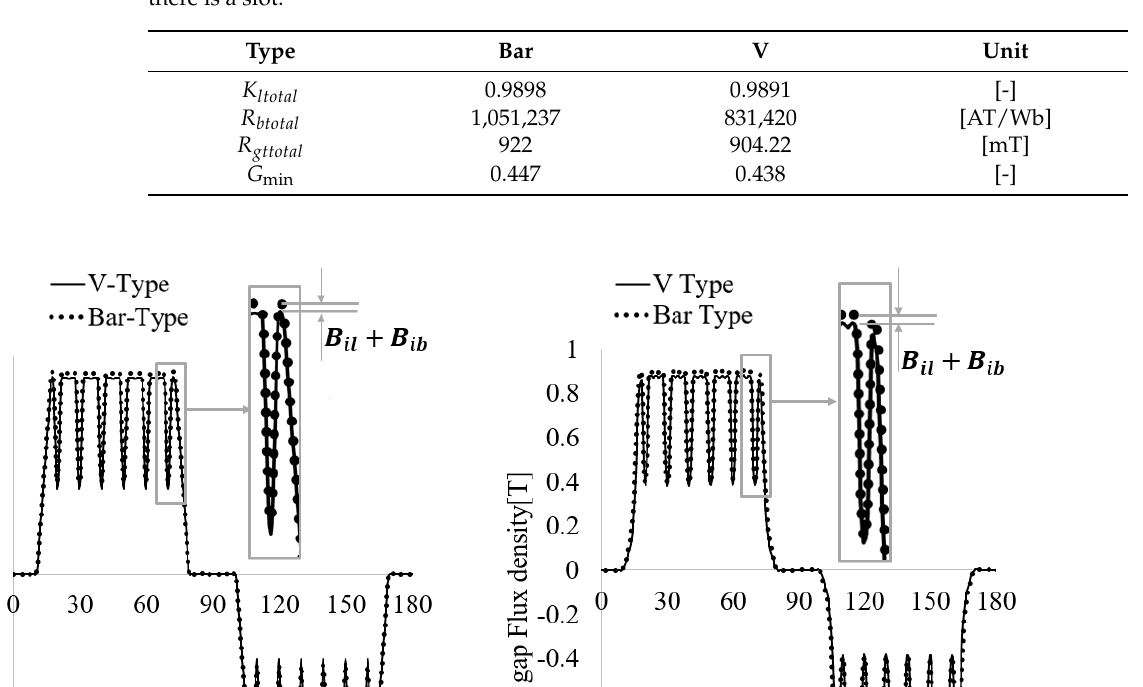
Figure 12. Magnetic equivalent circuit of a V-type rotor. Table 1. Comparison of magnetic field distribution parameters of bar-type and V-type rotor when there is a slot.